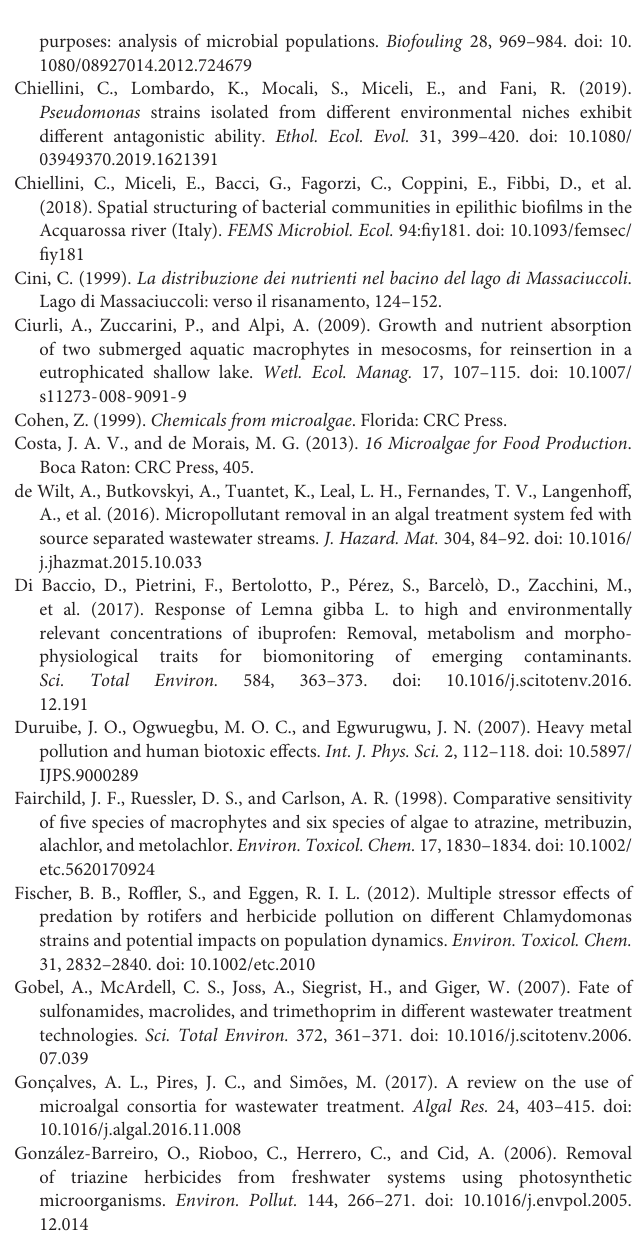
Supplementary Figure 1 | Comparison between the OD750 values, total chlorophyll and carotenoids content of the beginning (T0) and of the end T1